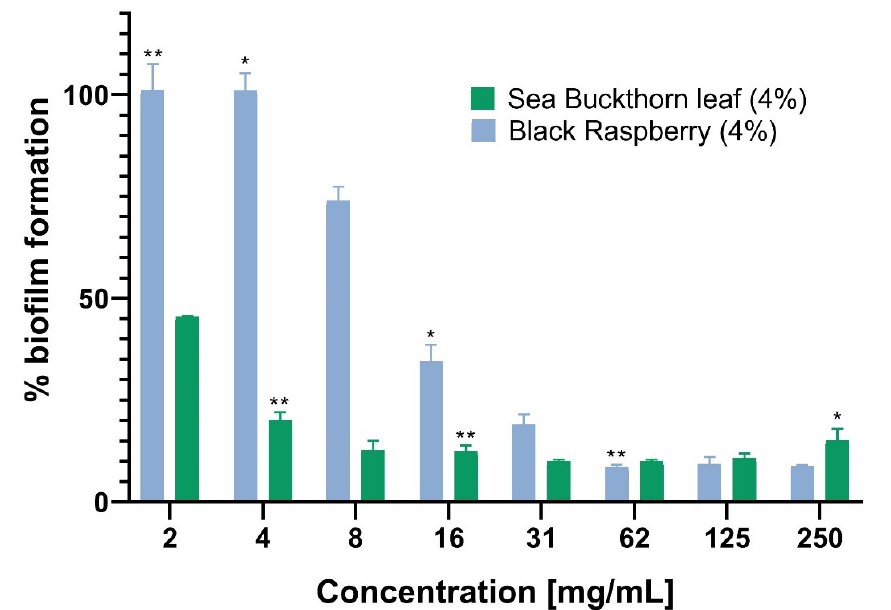
Figure 2. Antibiofilm activity of honey samples in two-fold decreasing concentrations against certified S. aureus . The results were determined in relation to a non-treated control (100% of biofilm formation). The error bars and asterisks represent the standard errors and statistical significance with the p -values: ** p < 0.01 and * p <